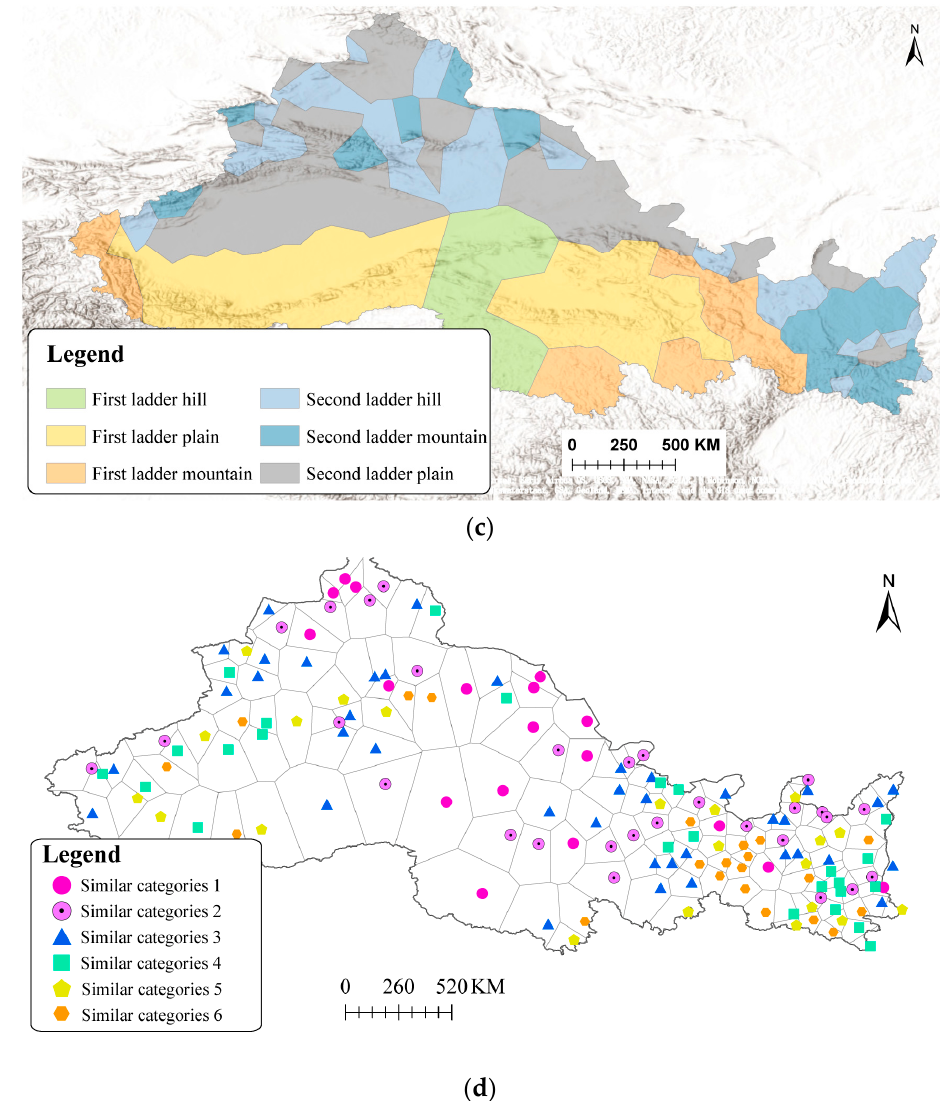
Figure 6. The process of small-area classification in northwest China. ( a ) Thiessen Polygon; ( b ) Terrain classification; ( c ) Terrain classification merged; ( d ) Classification of windy-year similarity.